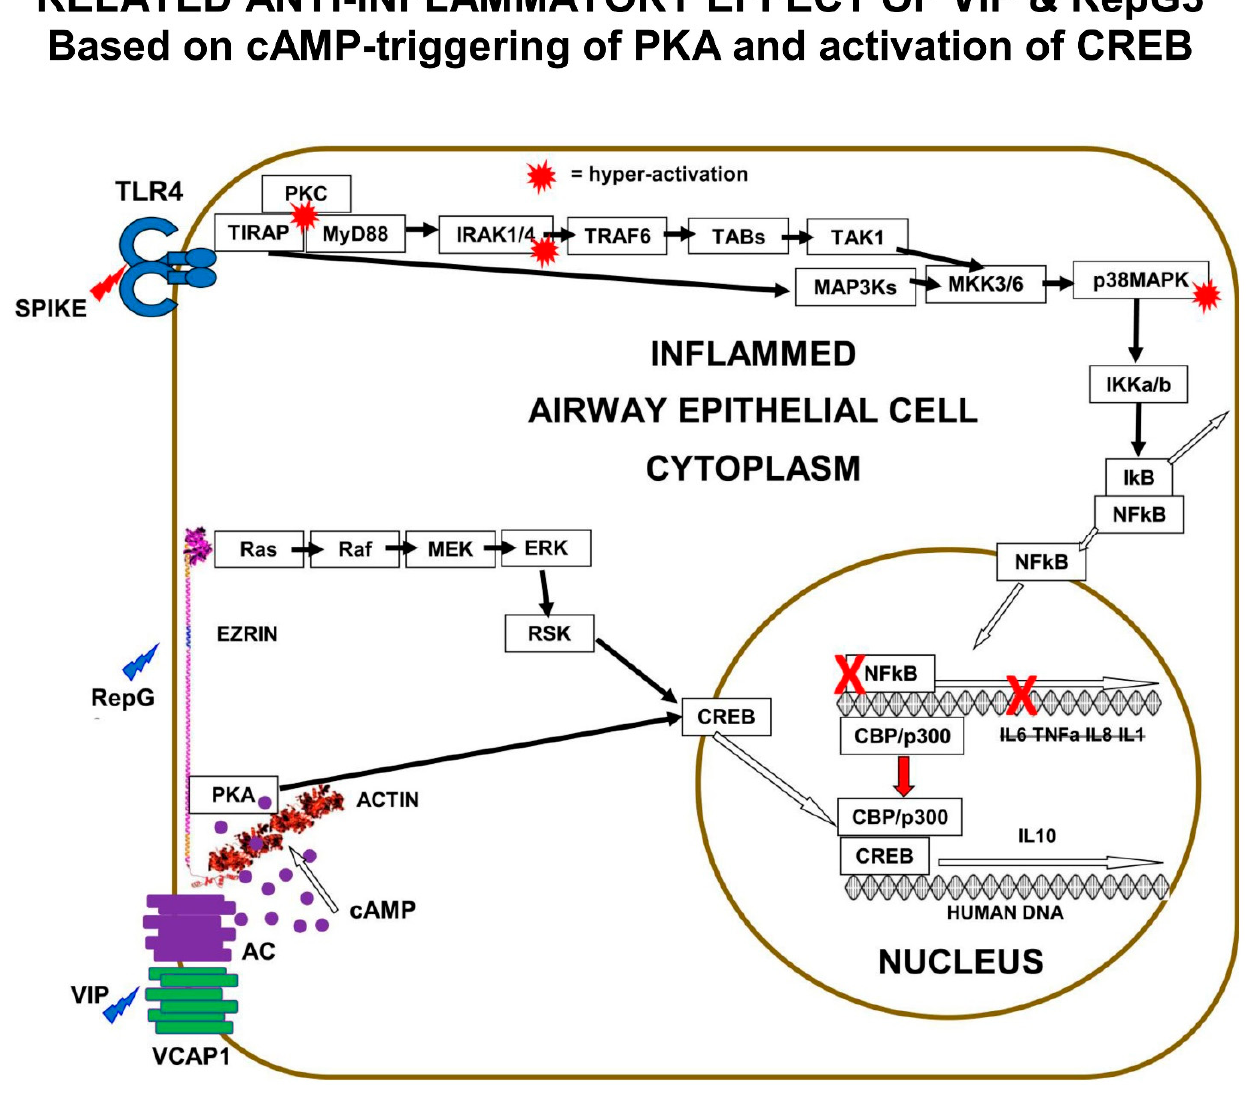
Figure 5. NF κ B transcription of pro-inflammatory cytokines depends on a transcription complex of NF κ B+CBP+p300. However, VIP binding its receptor VCAP1 stimulates AC to produce cAMP, which leads to PKA activation and CREB phosphorylation. Phospho-CREB migrates to the nucleus, where it scavenges CBP+p300, starving NF κ B, preventing pro-inflammatory cytokine expression. The CREB+CBP+p300 complex induces expression of anti-inflammatory IL-10. Ezrin peptides like RepG3 also phosphorylate CREB, either by activation of the Ras>Raf>MEK>ERK>RSK (ERK cas- cade) pathway or by stimulating PKA activity, and also result in inhibition of NFkB-mediated pro- inflammatory cytokine expression.